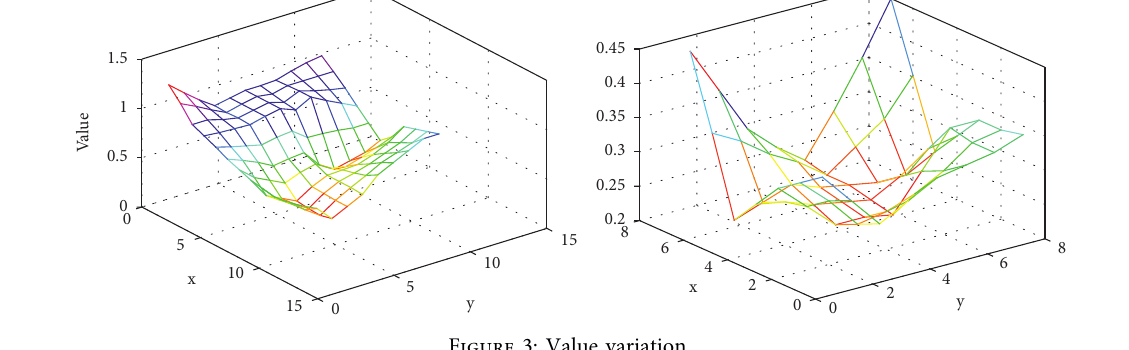
Figure 3: Value variation.